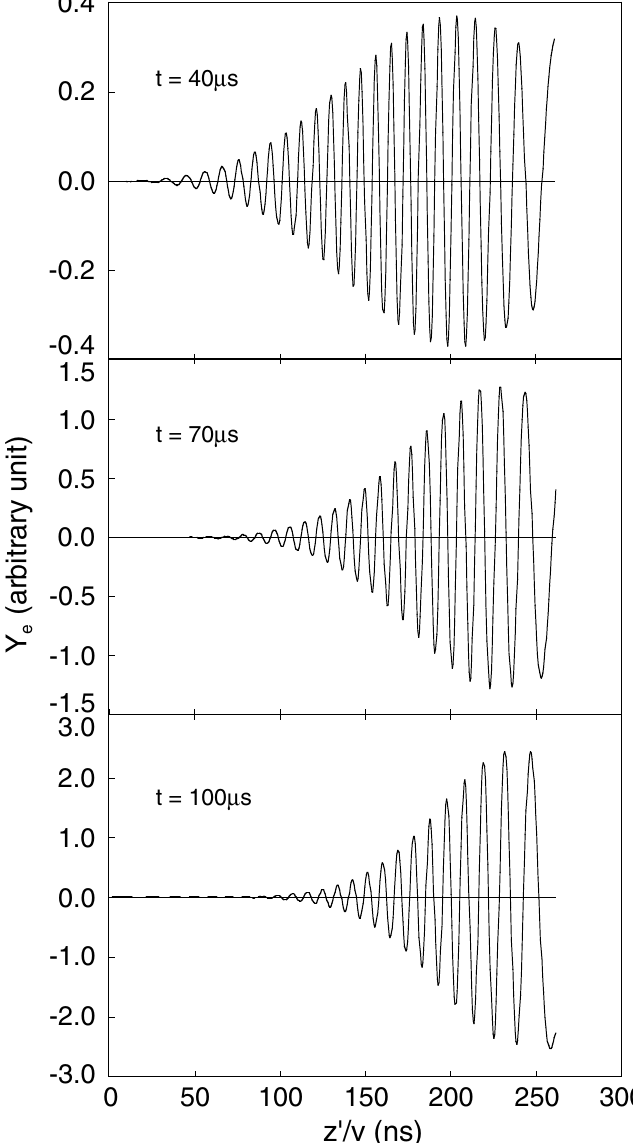
as a function of z 0 =v at time t (cid:1) 40 , 70, and 100 ( s . Here, the e (cid:1) (cid:22)= 2 and the parameter values described in the text. The proton bunch is 260 ns e